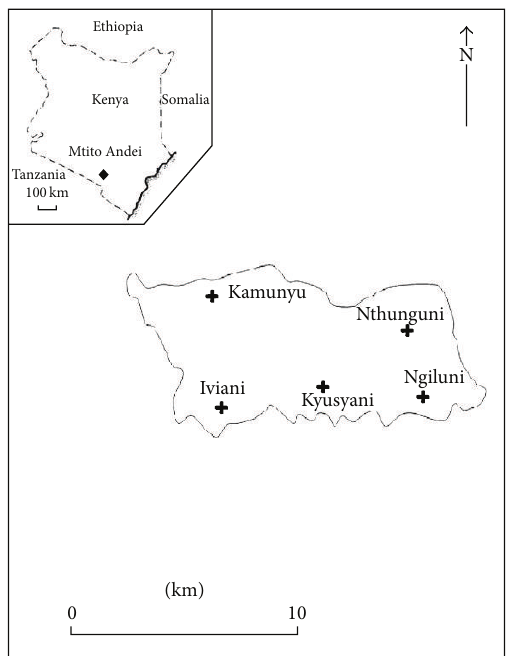
Figure 1: Map of Mtito Andei showing the georeferenced trapping sites.